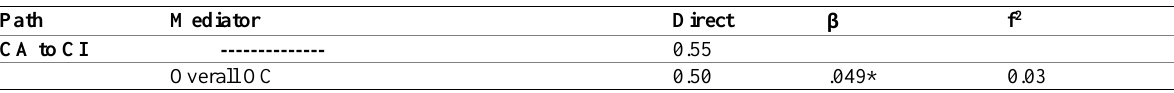
Table 3: Mediating effect of organizational climate (OC) on career adaptability (CA) and career intention (CI) Path Mediator Direct β CA to CI